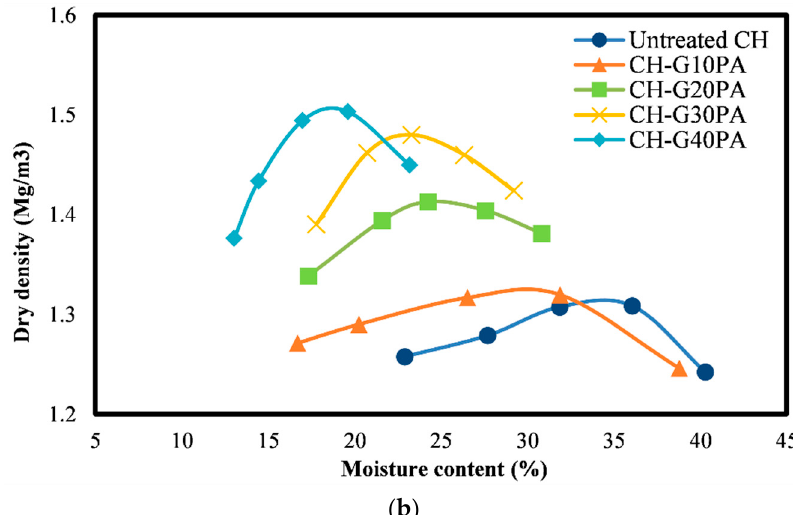
Figure 3. Moisture content-dry density relationships for soils treated with POFA-based geopolymer: ( a ) CL, ( b ) CH.